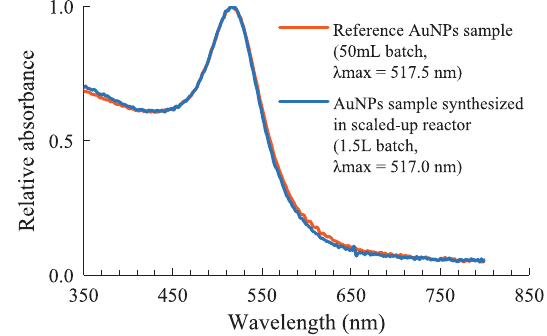
Fig. 7 Batch size had minimum effect on the UV-visible spec - trum of AuNPs synthesized (System: 0.25 ml HAuCl 4 , 1 wt% NaCt, MR = 2.80, 100 °C reaction